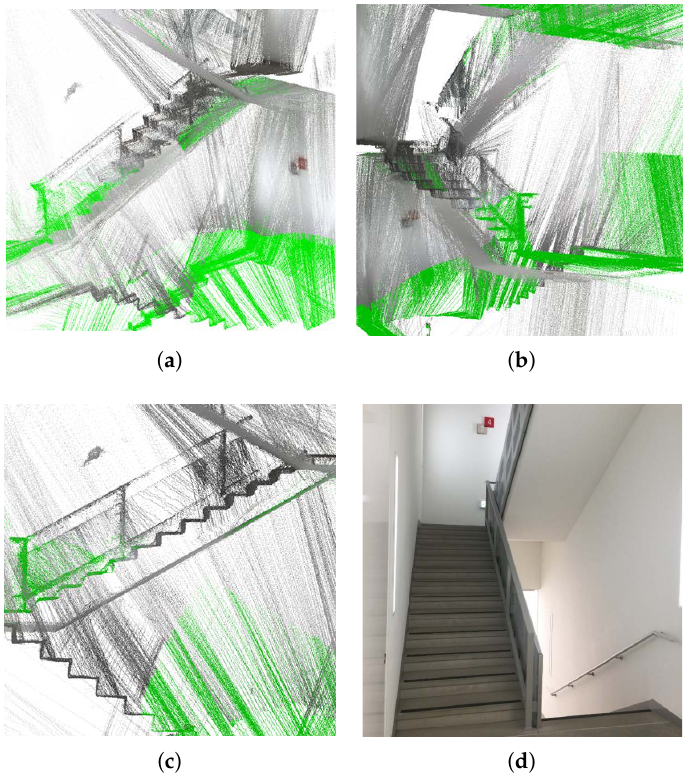
Figure 10. Reconstruction results: ( a – c ) detailed views of the result with color information; ( d ) real